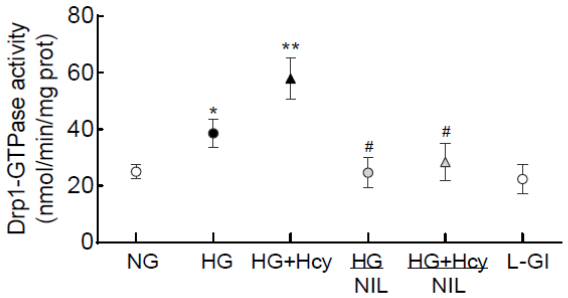
Figure 3. Effect of homocysteine on GTPase activity of Drp1. GTPase activity of Drp1 was measured in the Drp1-immunoprecipitated samples, and the release of phosphate was quantified spectrophotometrically. The values are represented as mean ± SD obtained from 4–5 different cell preparations with each measurement made in duplicate. * p < 0.05 vs. NG; ** p < 0.05 vs. HG; # p > 0.05 vs. NG.